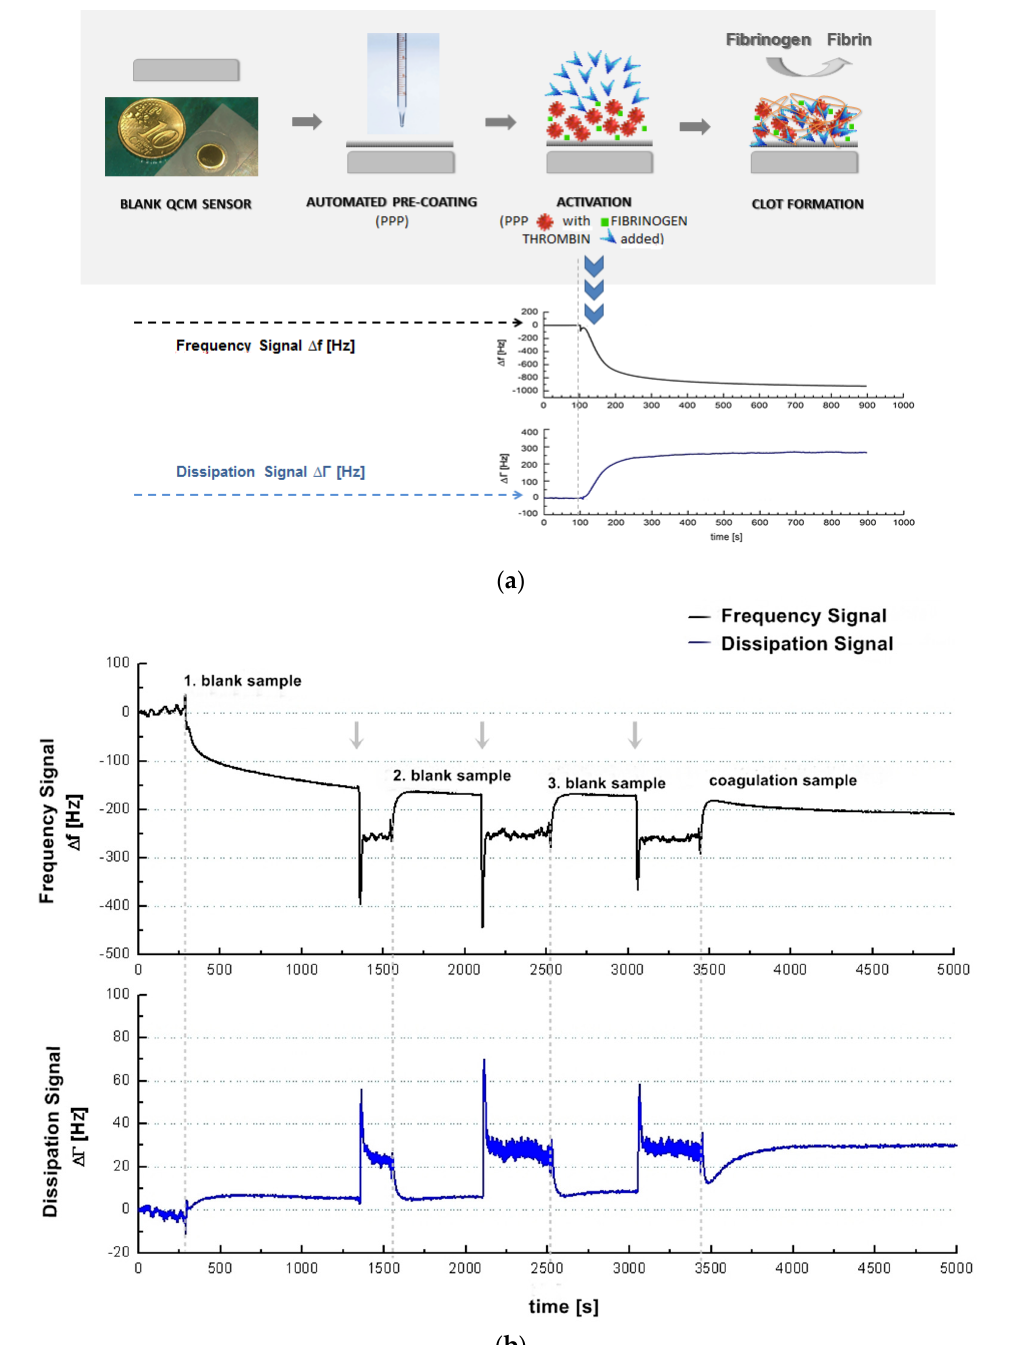
Figure 1. Cont . Figure 1.